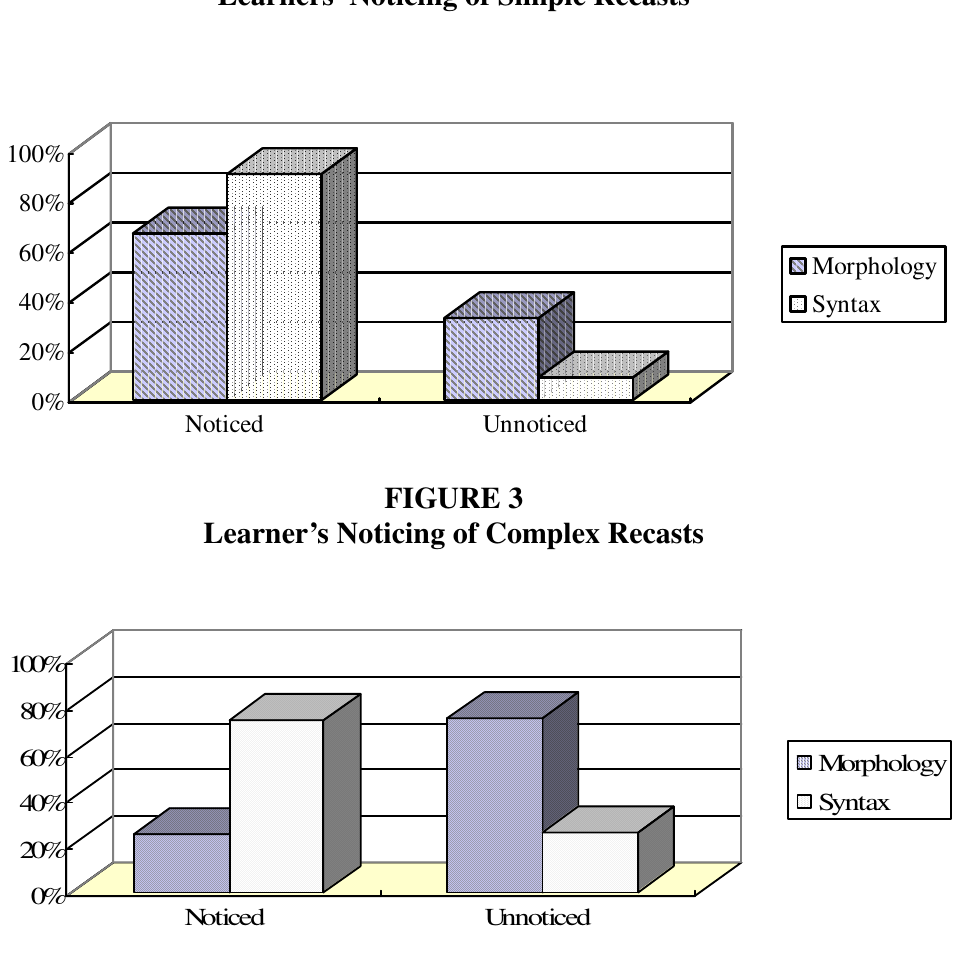
Learners’ Noticing of Simple Recasts